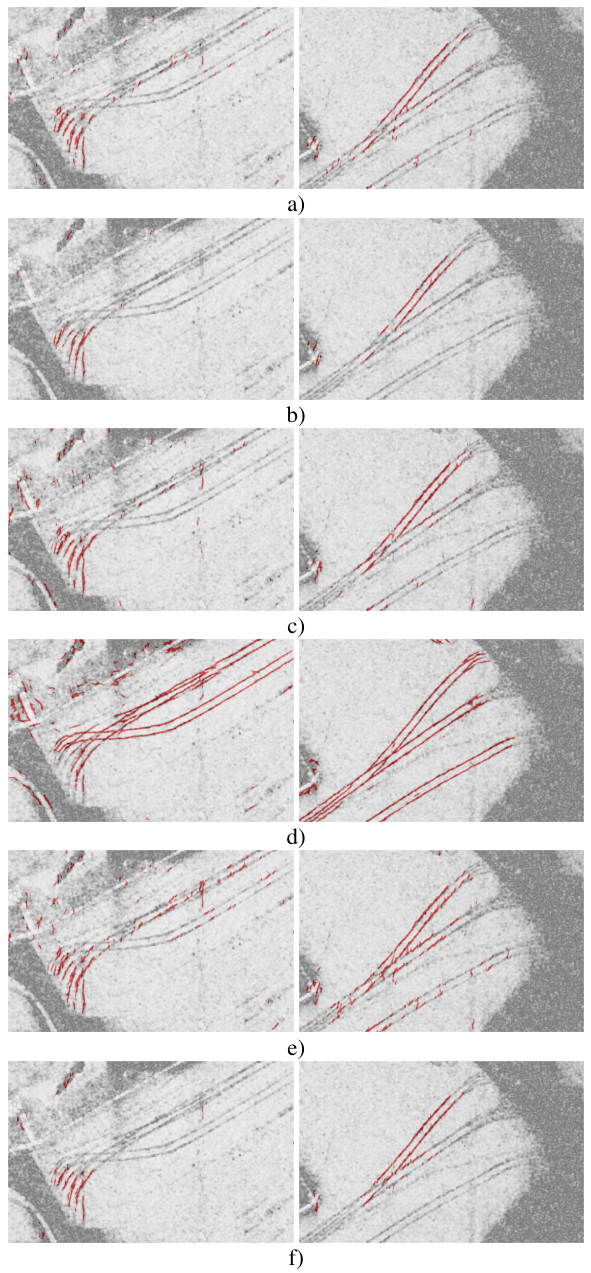
Figure 7. Segmentation results (red) superimposed on the coherence image C 6 , regarding the network training with data sets: a) DS orig , b) DS A , c) DS B , d) DS C , e) DS D , f) DS E .